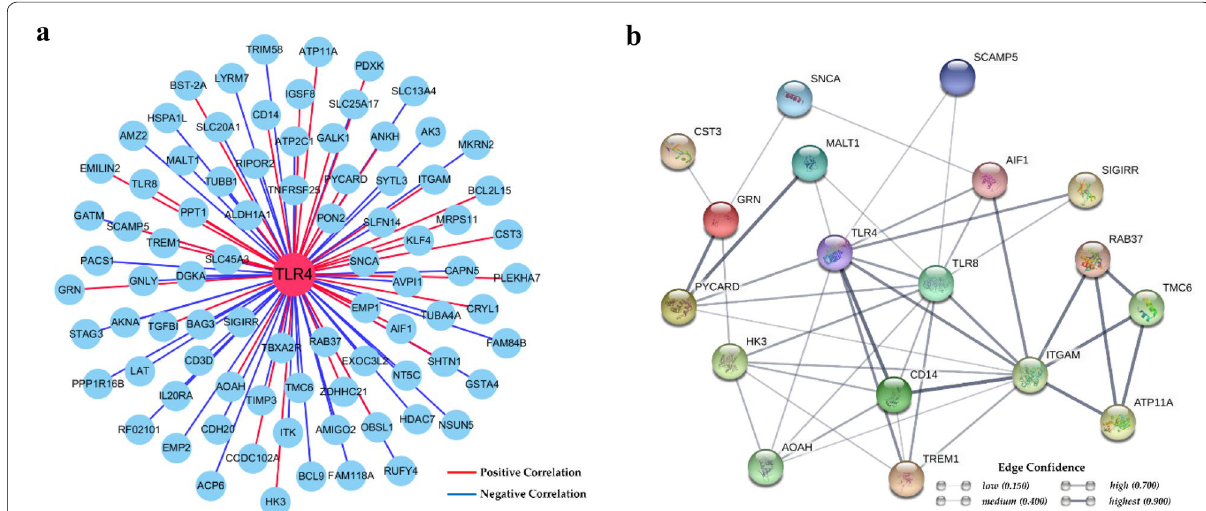
Fig. 5 Analysis of the genes associated with the expression pattern of TLR4 . a The mRNAs of 84 known genes that are strongly associated with the expression pattern of the TLR4 gene. The red line represents a positive correlation, and the blue line represents a negative correlation. b The interaction network of 18 proteins backed up by the human database in String